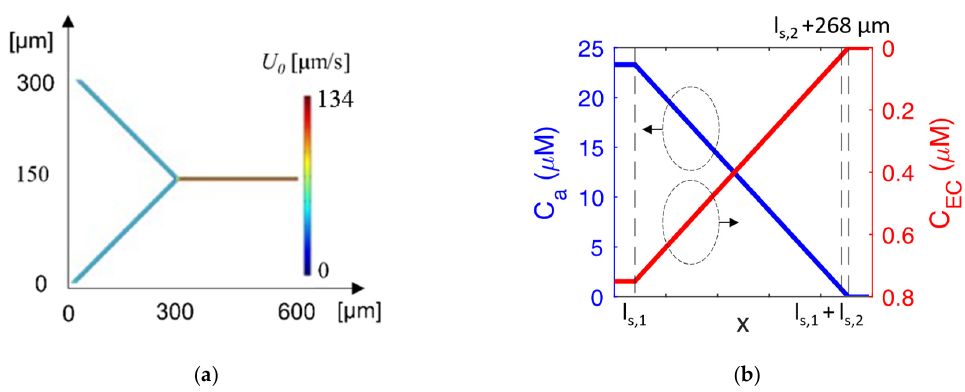
Figure 3. ( a ) Magnitude of the fluid velocity at the micromixer input joint; ( b ) concentration trend of antibiotic (blue curve) and EC (red curve) along the serpentine channel.